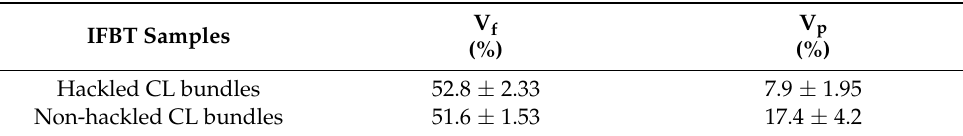
Table 3. Porosities ( V p ) and fibers ( V f ) volume fractions in IFBT